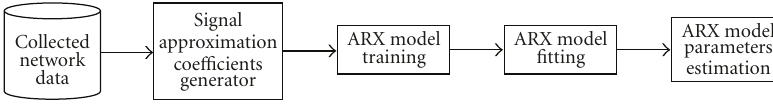
Figure 4: Procedure for modeling normal network tra ffi